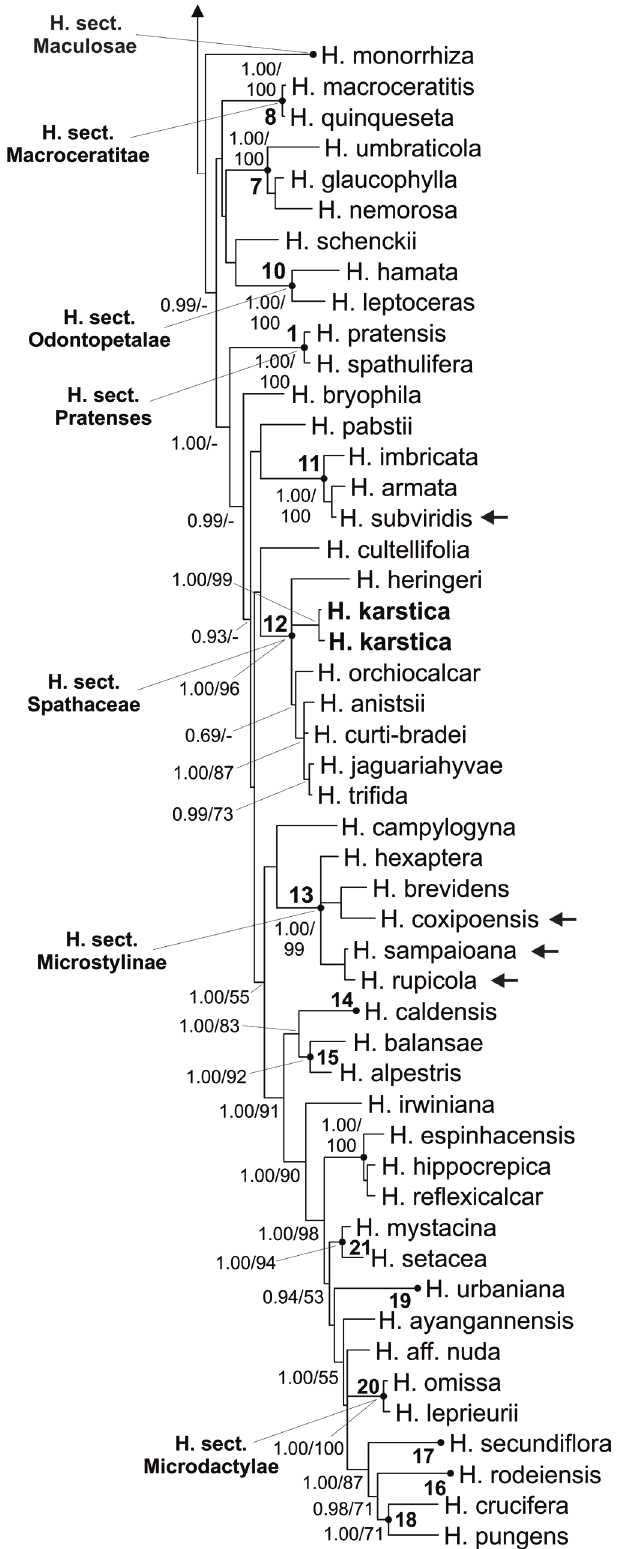
Fig. 1 (part 2). Bayesian 50% majority-rule consensus tree of the combined ITS, ETS, matK-trnK and rps16-trnK